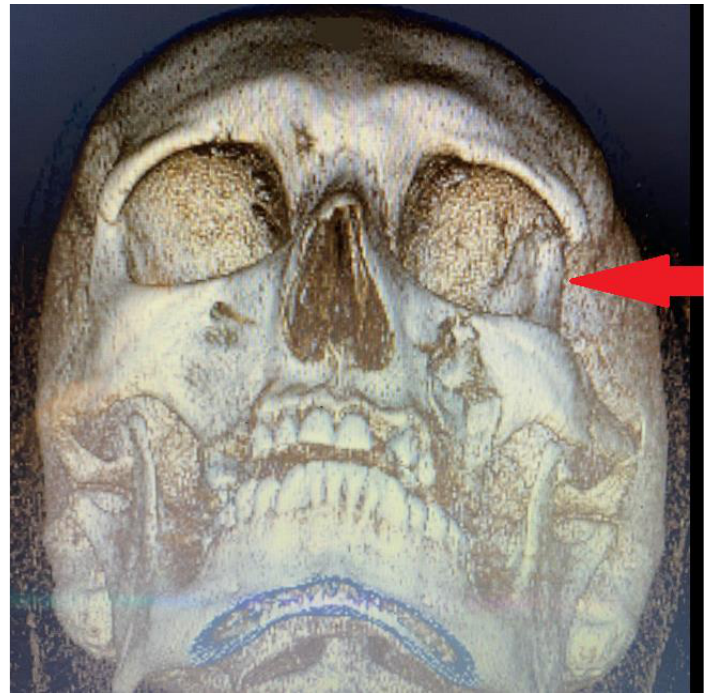
Figure 6. The major scope of 3D-reconstruction is focused on the decreased volume of the left orbital socket because of the degree of bone displacement towards the eye socket (red arrow). No zygomatic bone-coronoid process of the mandible conflict was present.